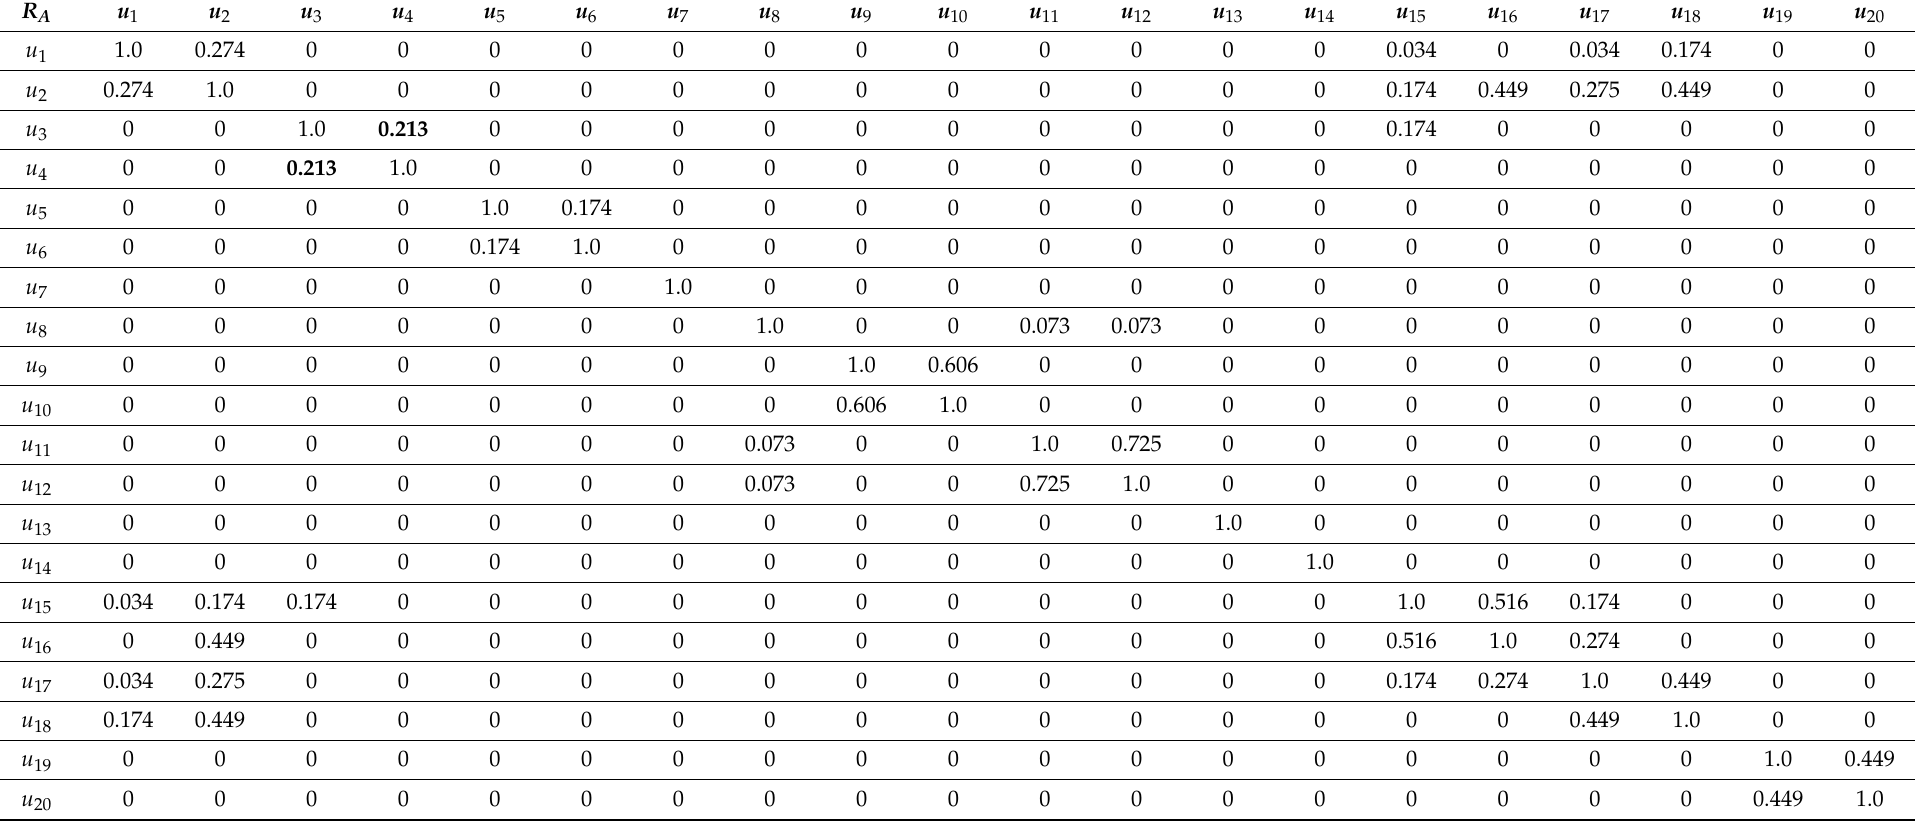
Table A3. Valued tolerance relation matrix, R A